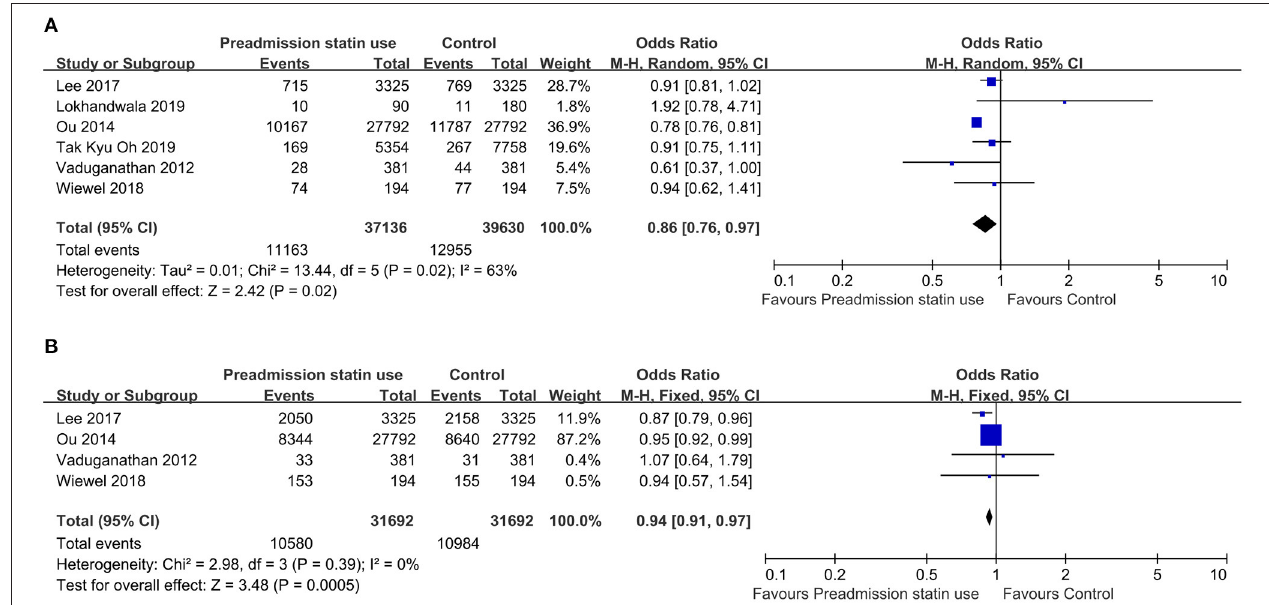
FIGURE 2 | (A) Forest plot of overall mortality comparing preadmission statin use to no use in critically ill patients. (B) Forest plot of mechanical ventilation comparing preadmission statin use to no use in critically ill patients. CI, confidence